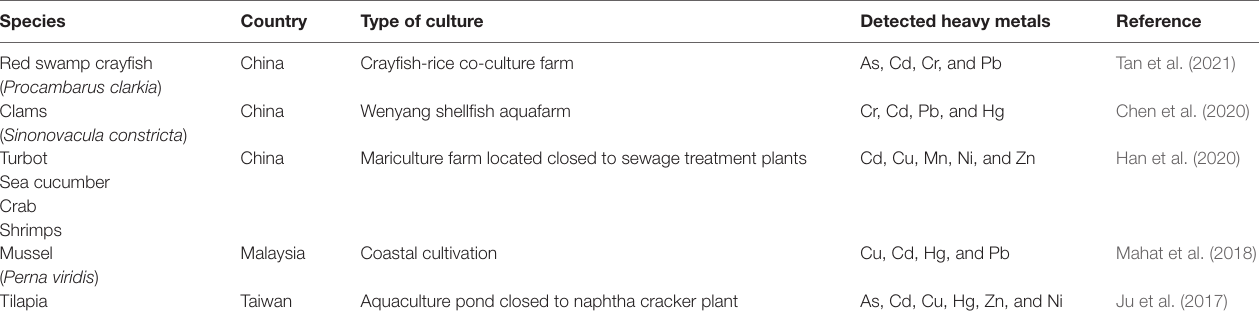
TABLE 3B | Detection of heavy metals in aquaculture organisms. Species